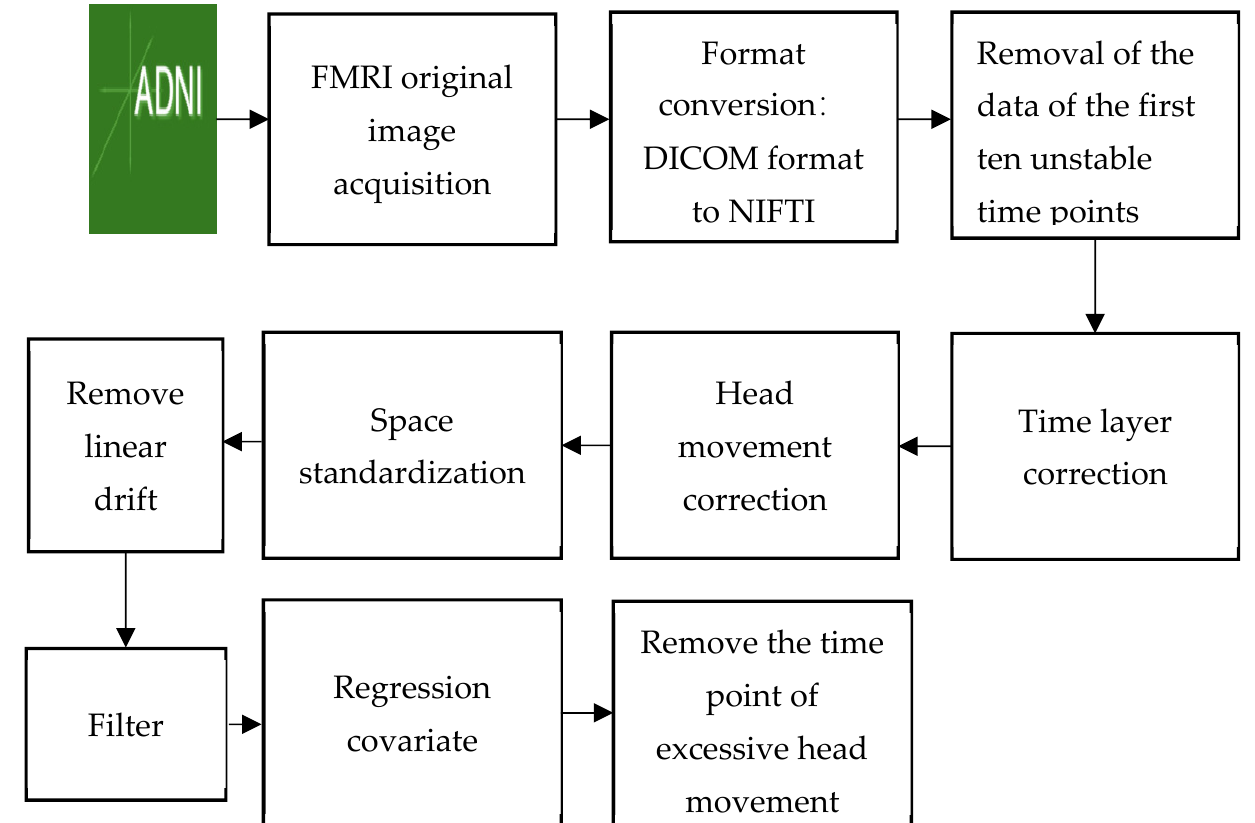
Figure 2. Pretreatment flow chart.